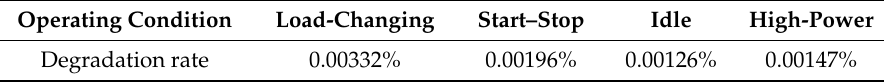
Table 2. Fuel cell stack degradation rates (1 /